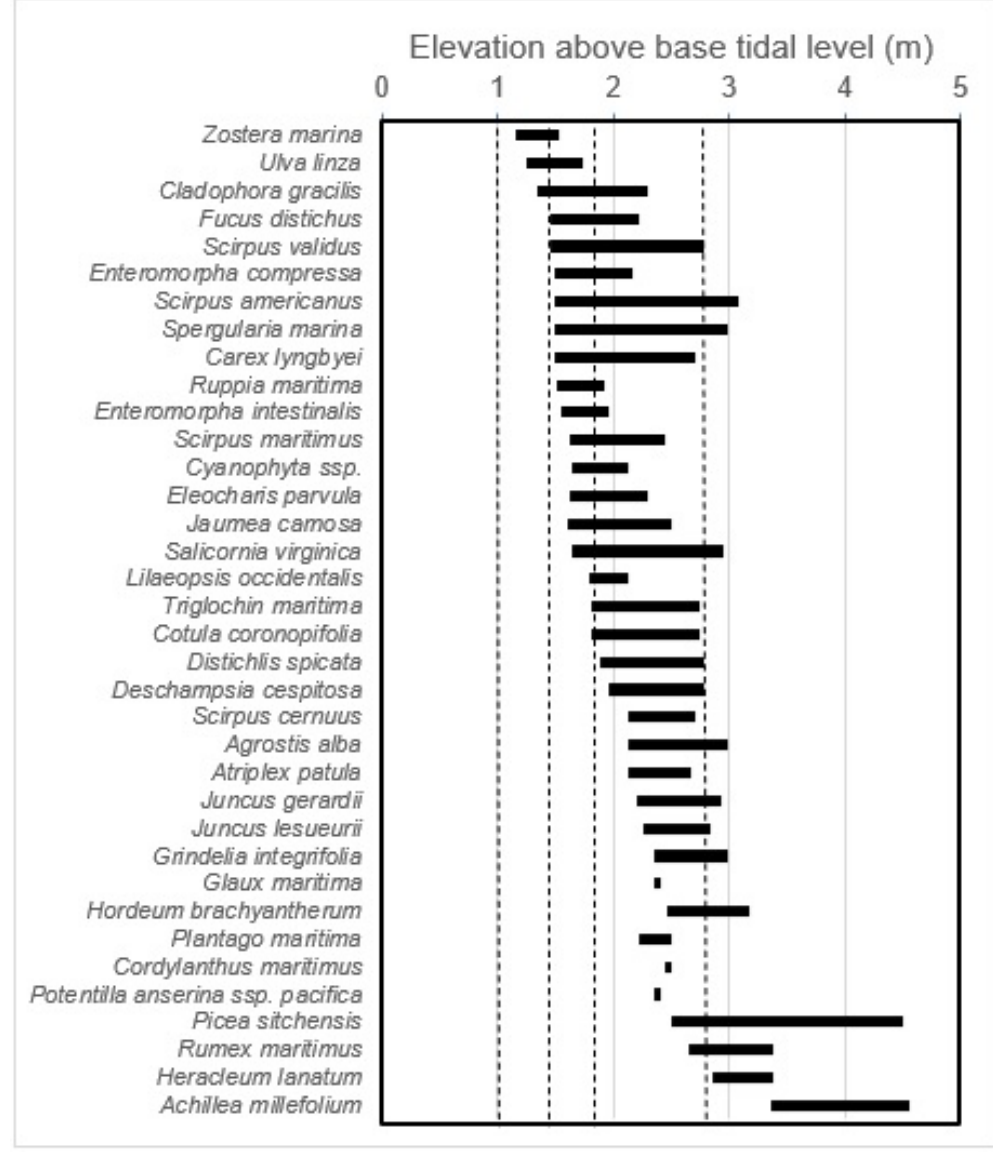
Figure B2. Reference used for determining marsh stratum based on vegetation, adapted from Deur (2000). Dashed vertical lines from left to right represent mean time (1m), mean lower high water (1.5m), mean higher high water (1.85m), and maximum water level (2.85m).